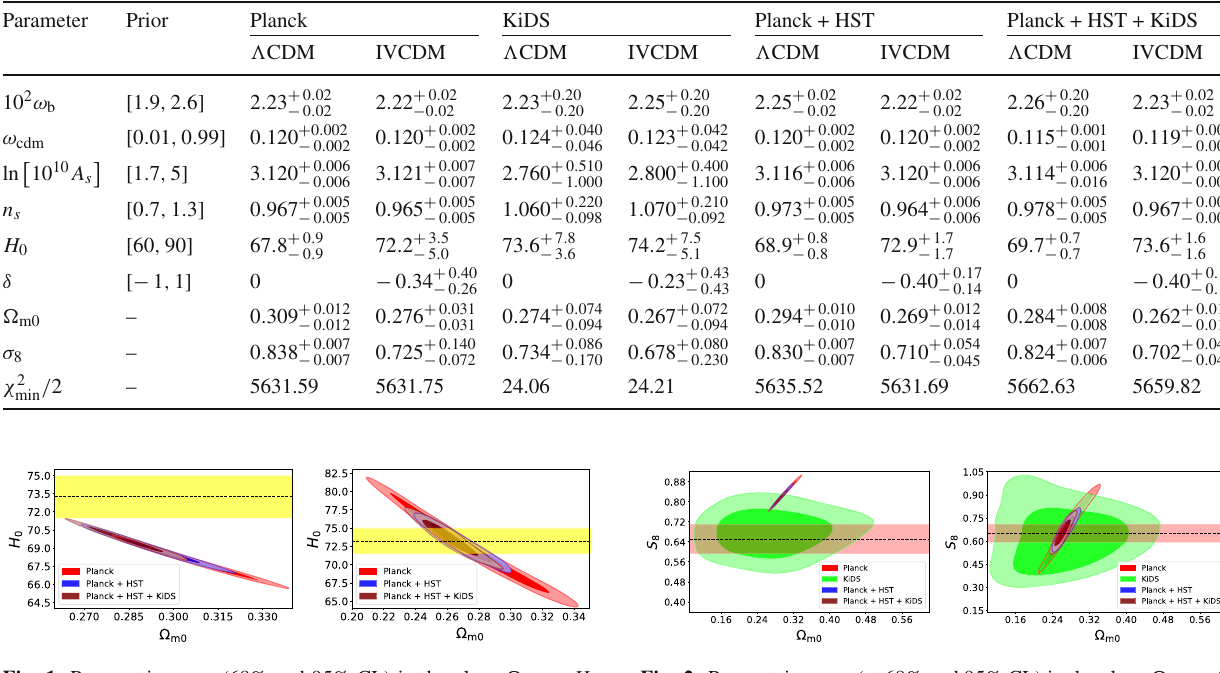
space is shown for the IVCDM model, where we observe that there is no tension on H 0